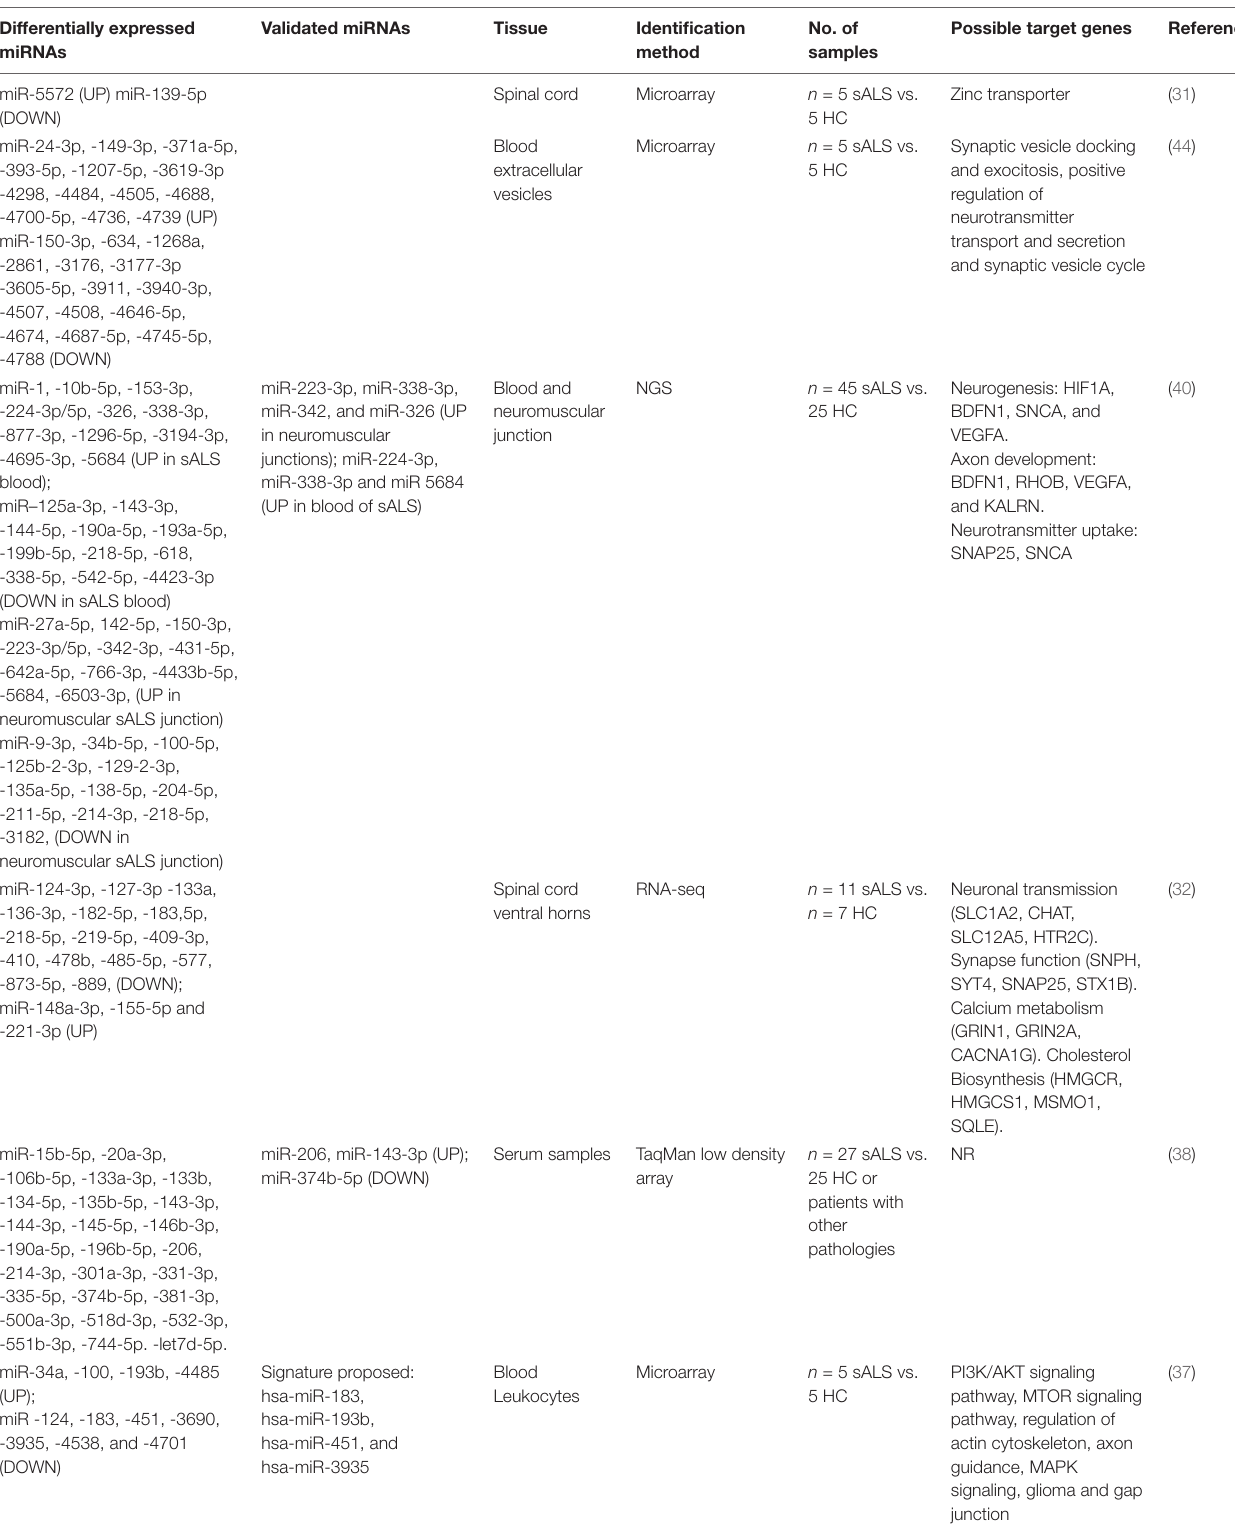
TABLE 1 | Summary table of miRNA associated to sALS (NR = not